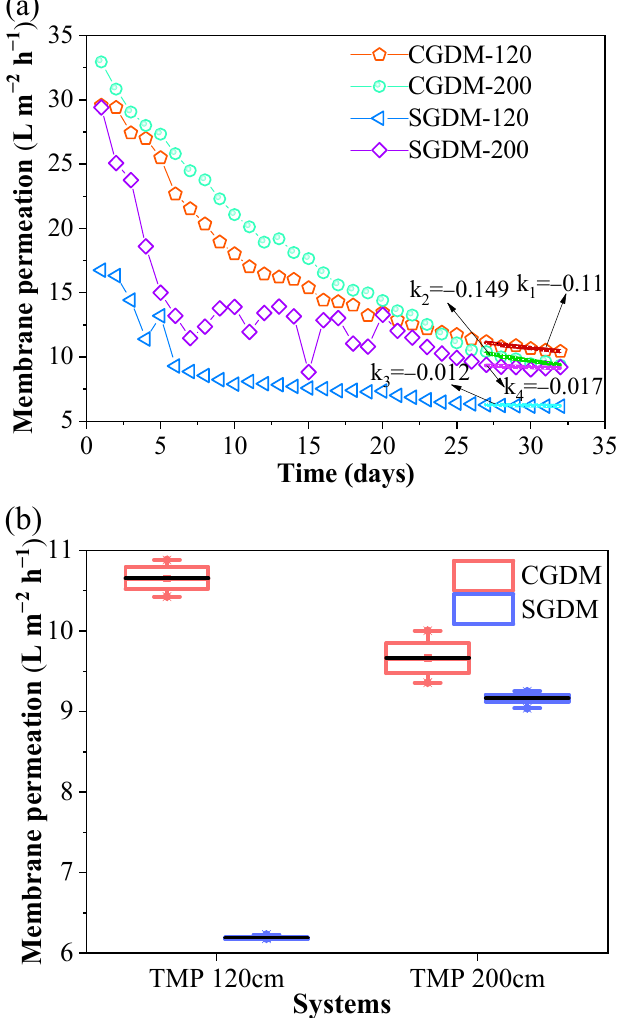
Figure 2. Trends of membrane permeation and membrane resistance: ( a ) membrane permeation, ( b ) stable membrane permeation (28–32 days).